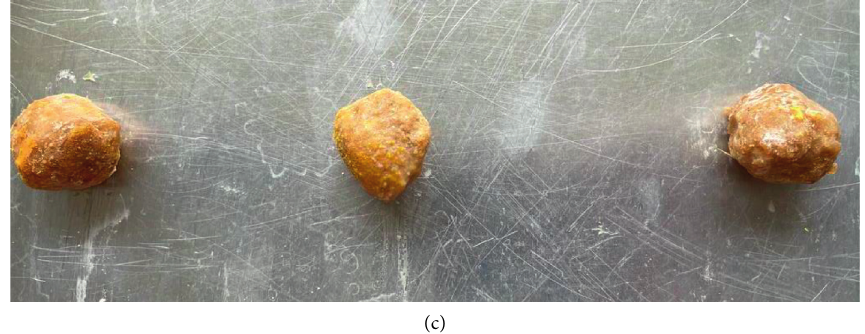
Figure 3: The condition of tested samples at various storage times ((a) 0 h, (b) 24h, and (c)